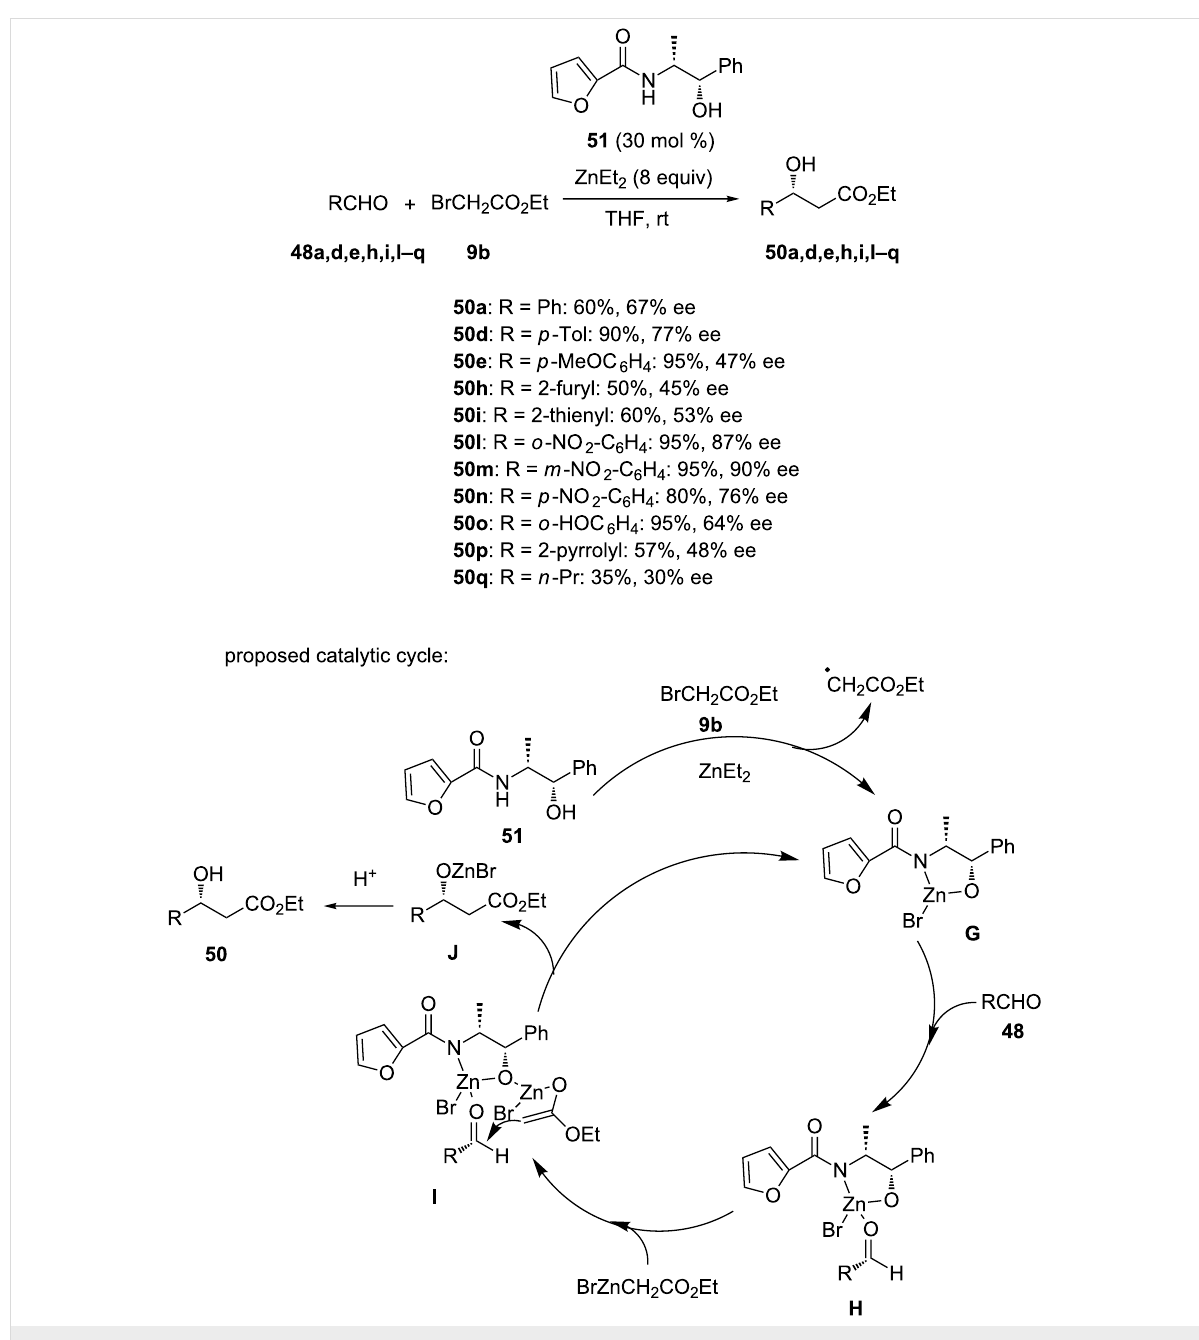
Scheme 20: Reformatsky reaction of aldehydes with ethyl bromoacetate in the presence of a chiral amide ligand